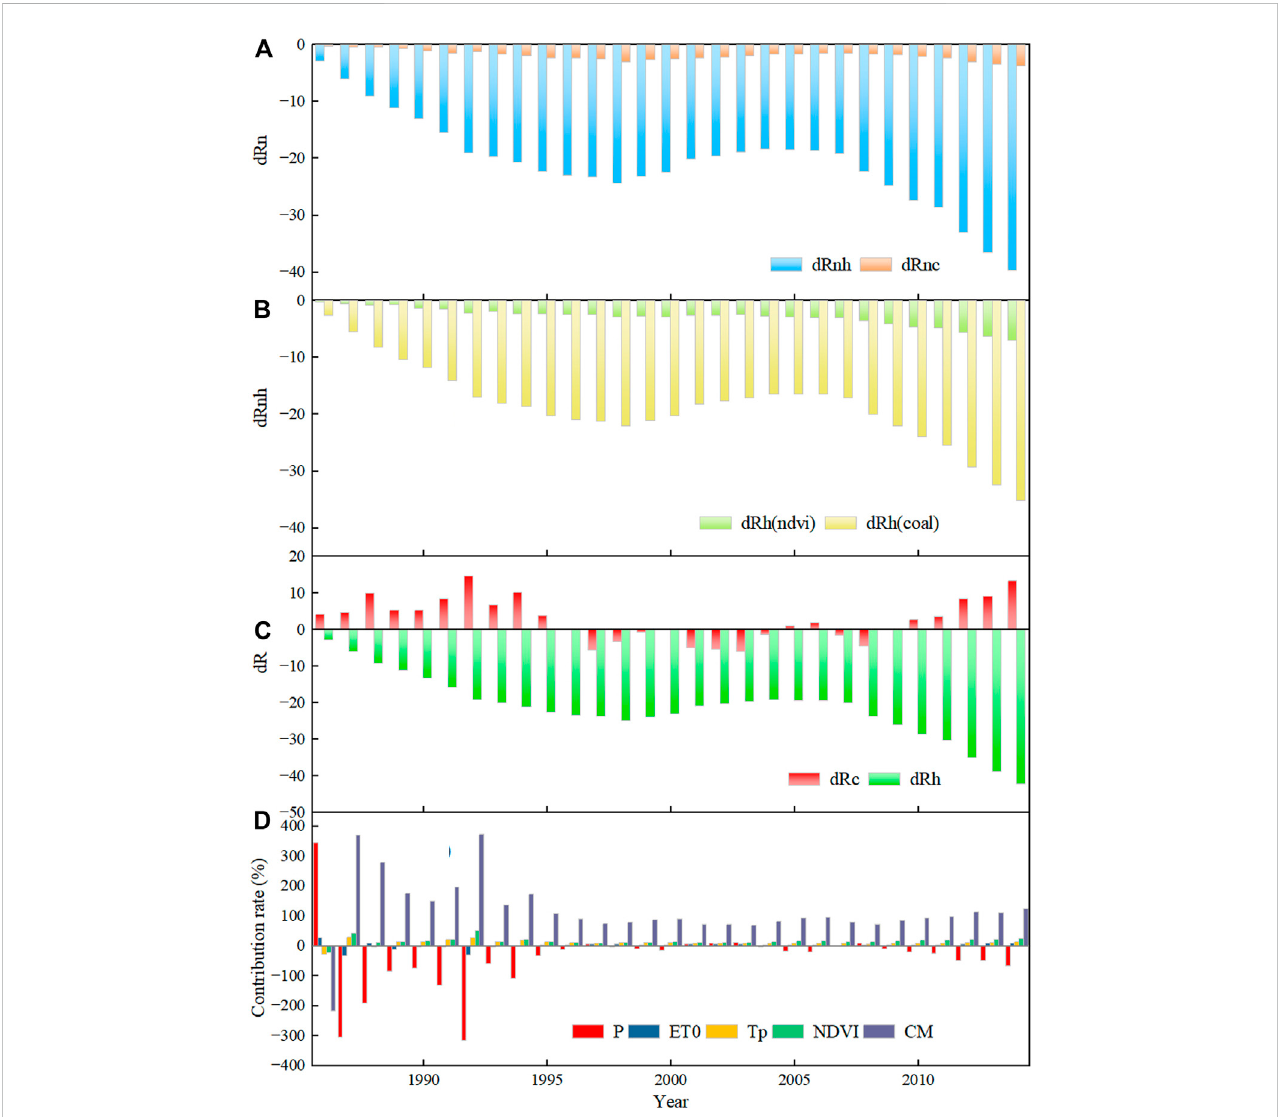
FIGURE 4 Attributionandcontributionrateanalysis ofvariablestorunoff: (A) underlying surfaceparametersofn h andn c , (B) NDVIandCoalMining, (C) Climateand human activities, and (D) contribution rate of runoff to each factor.